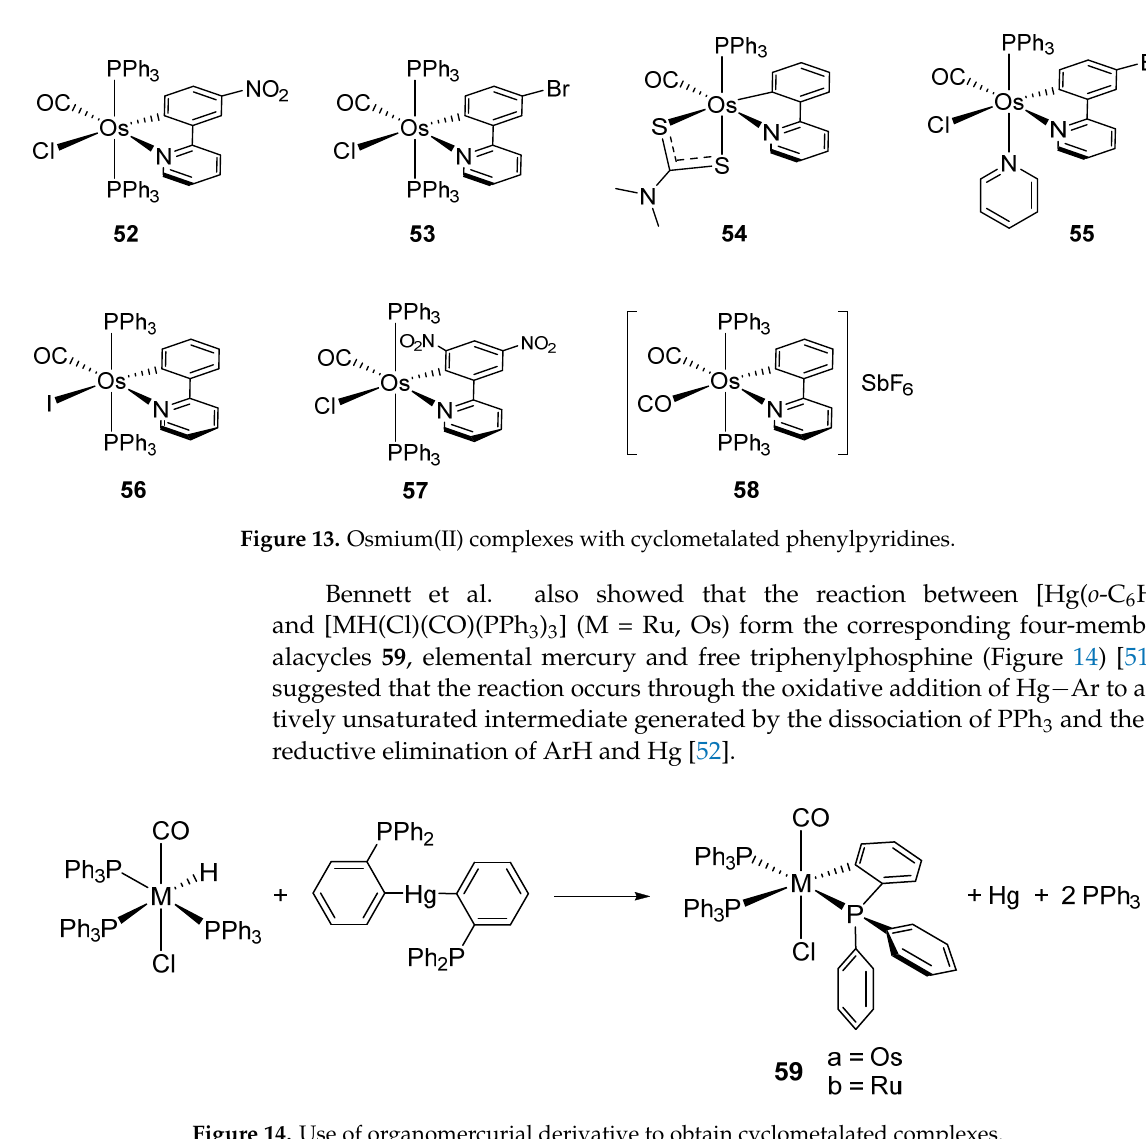
Figure 14. Use of organomercurial derivative to obtain cyclometalated complexes.